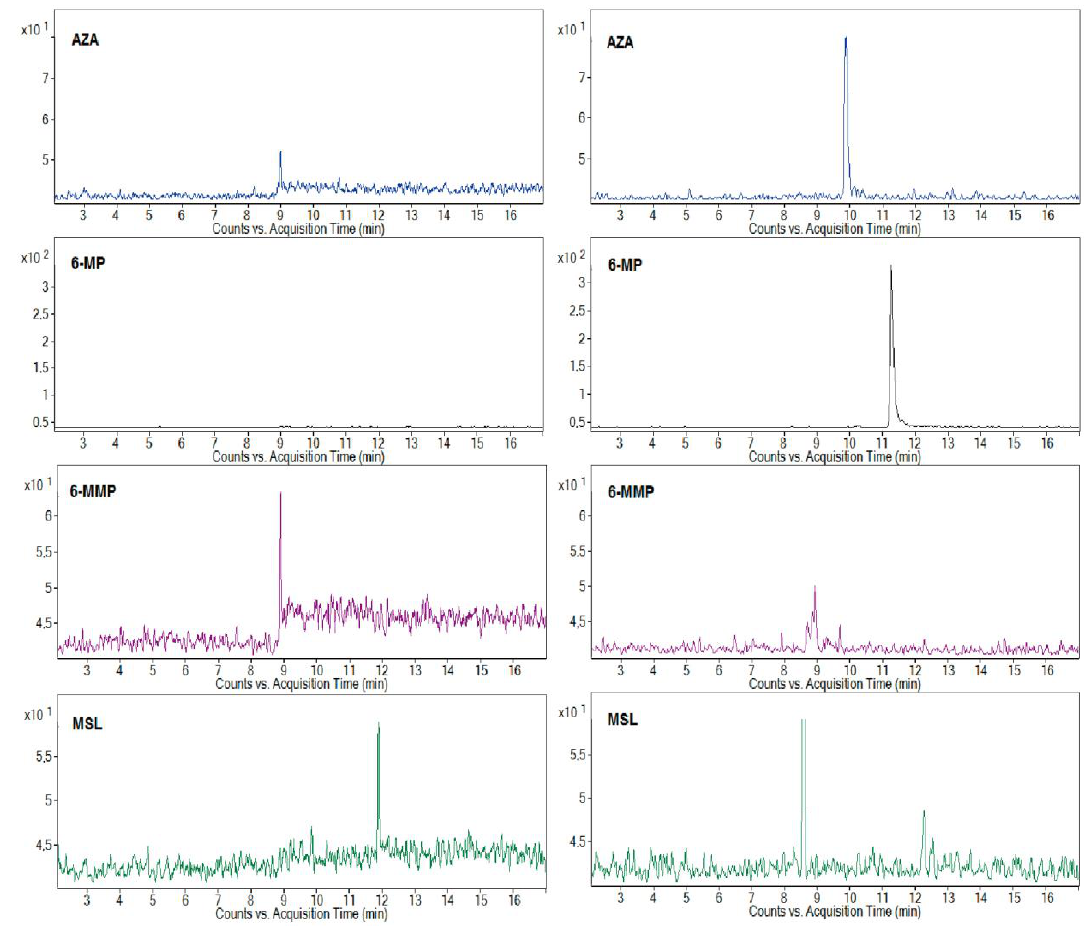
Figure 2. Analysis of clinical human urine sample. MRM transitions from CE-ESI-MS/MS analysis of 10-fold diluted human urine sample were obtained from the patients treated by azathioprine with a daily dosage of 50 mg ( left panel) and 100 mg ( right panel), and a mesalazine co-medication. For the preparation of the sample and other working conditions, see Section